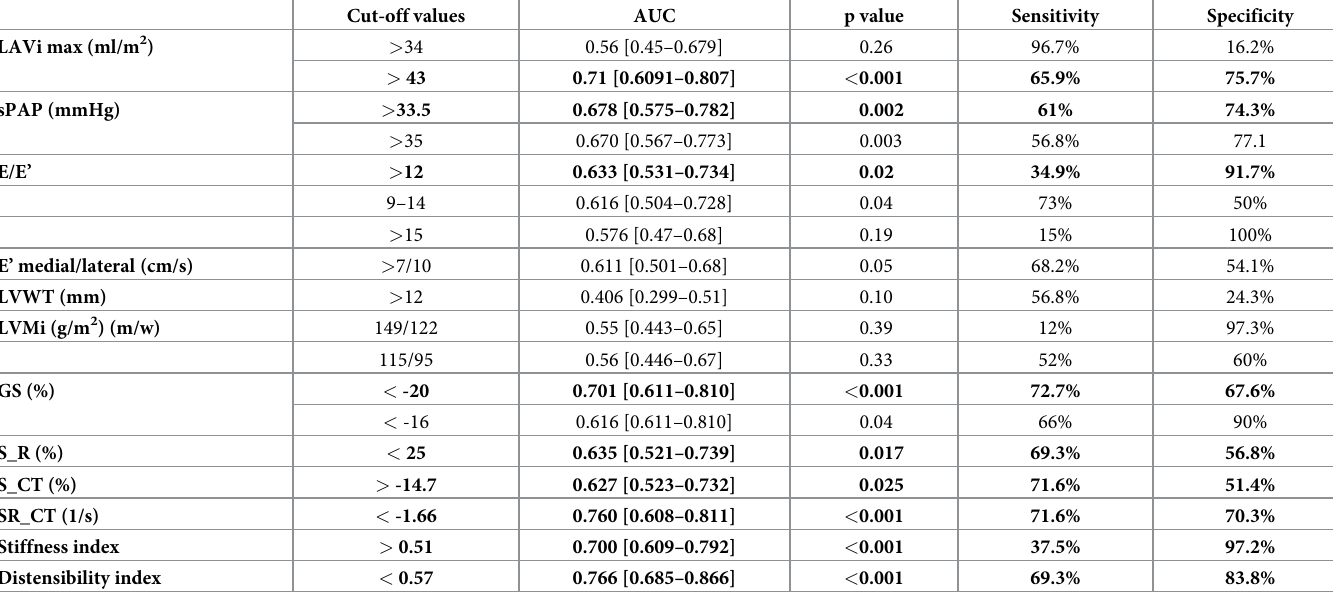
Table 6. Diagnostic accuracy for HFpEF diagnosis of the guideline and new suggested echocardiographic